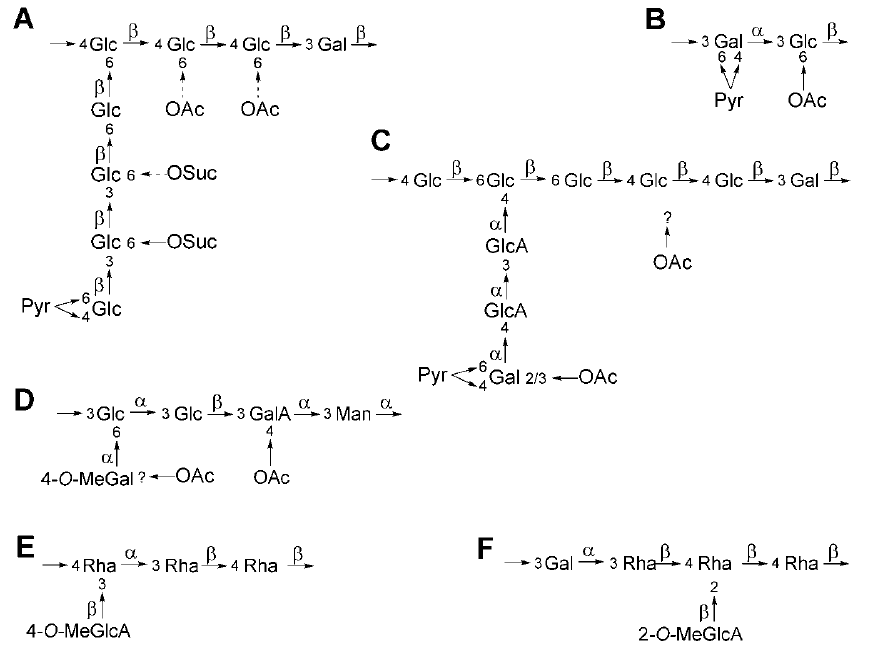
Figure 3. Structure of the EPS (and NPS) produced by different sino- and bradyrhizobia. Sinorhizobium meliloti 1021 EPS I ( A ) and II ( B ); Sinorhizobium fredii HH103 and NGR234 EPS ( C ); Bradyrhizobium japonicum USDA110 EPS ( D ); Bradyrhizobium elkanii USDA61 EPS/NPS ( E ); and B. japonicum USDA110 NPS ( F ). Dashed arrows indicate partial substitutions. α and β : α - and β -glycosidic linkages. ?: the position of the O -acetyl group is unknown.